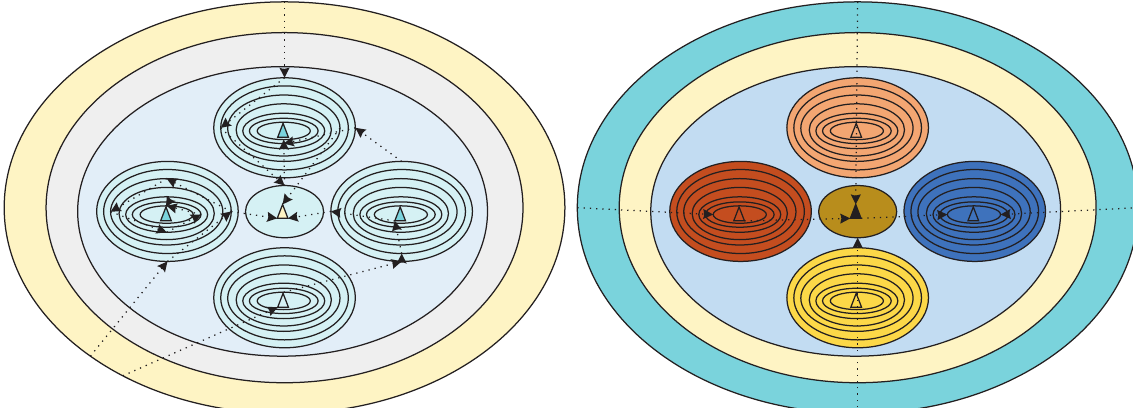
Figure 2: Schematic of BP algorithm and neuroevolutionary approach to